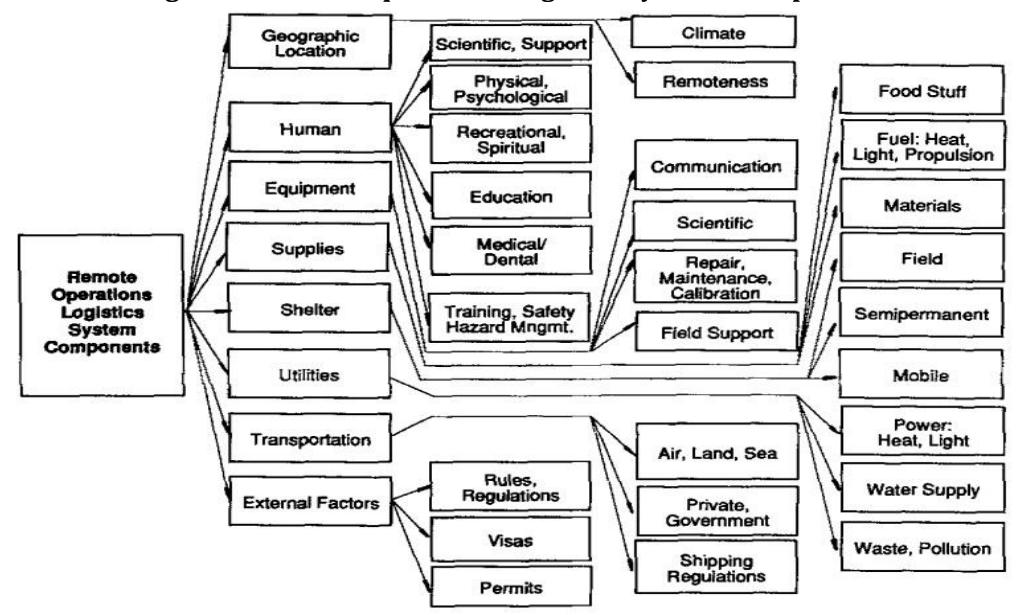
Source : (Hulsey et al, 1993, p.